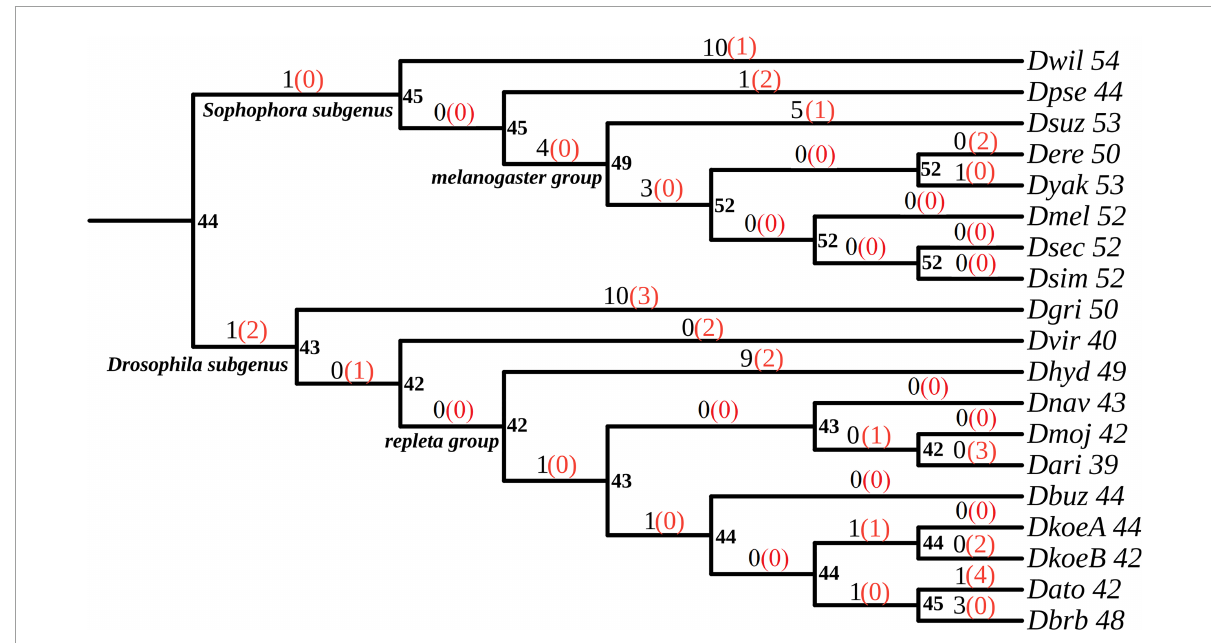
FIGURE3 Phylogenetic tree showing OBP births (gains) and losses in Drosophila species. Values were obtained with BadiRate under the birth-death-innovation (BDI) model class with the BDI-GR-ML approach. Numbers next to the species names represent the OBP family size. Numbers at internal nodes represent the estimated family size of each ancestor. Numbers on each branch stand for the estimated gene gains (black) and losses (red, in parentheses).